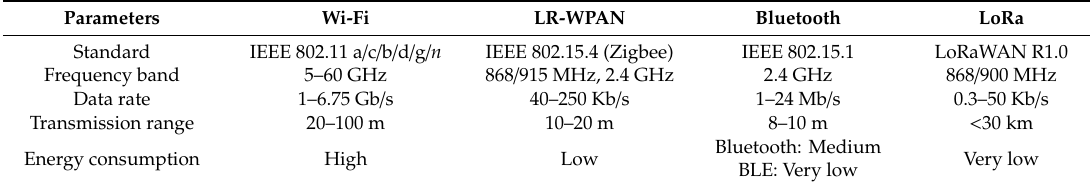
Table 1. Comparison of typical wireless communication technologies